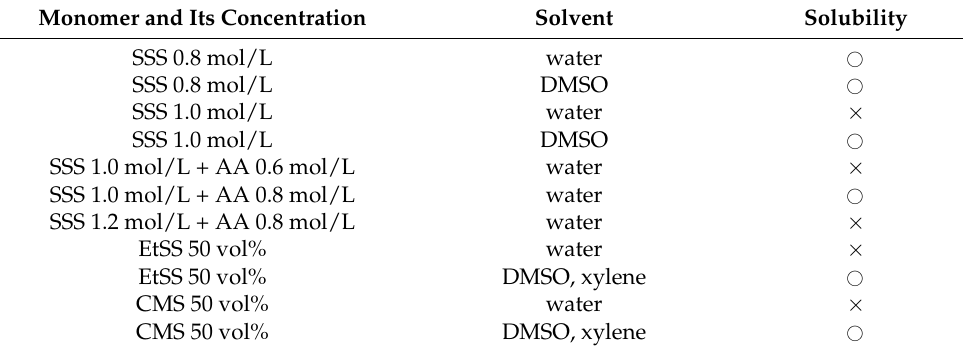
Table 2. Dissolution behavior of four monomers in various solvents. Monomer and Its Concentration Solvent